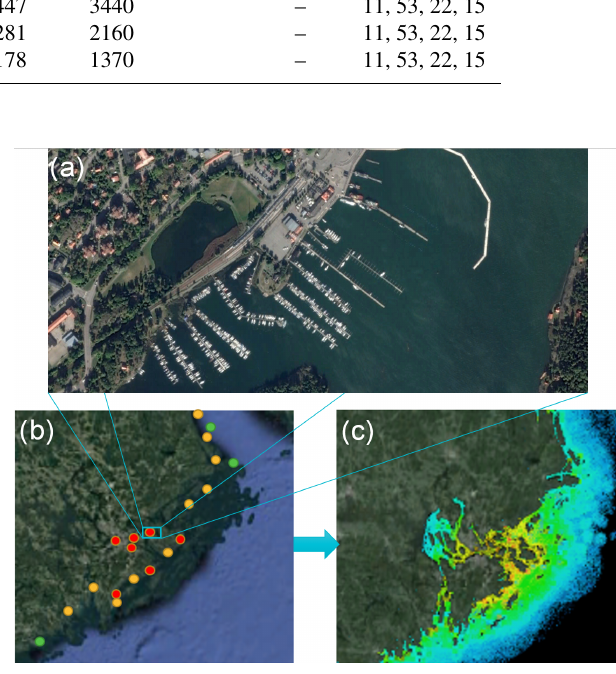
on both the coastline distance and the marina distance.